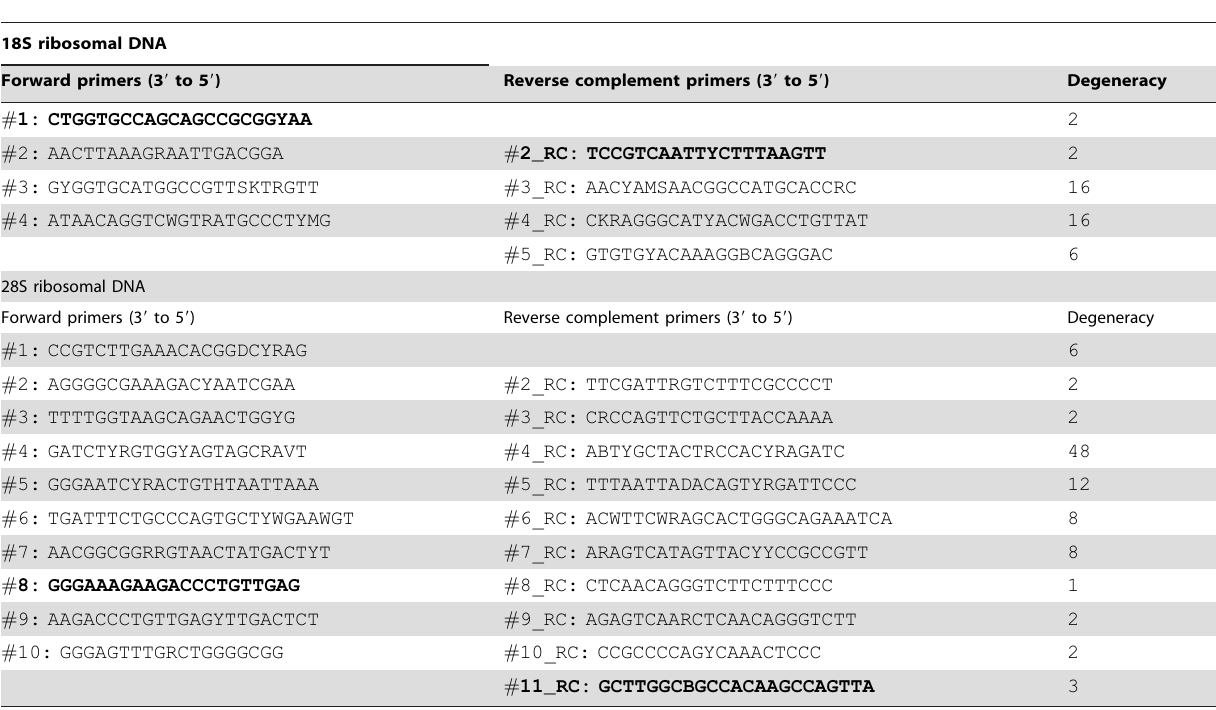
Table 1. List of the 18S and 28S ribosomal DNA primers designed in this study.